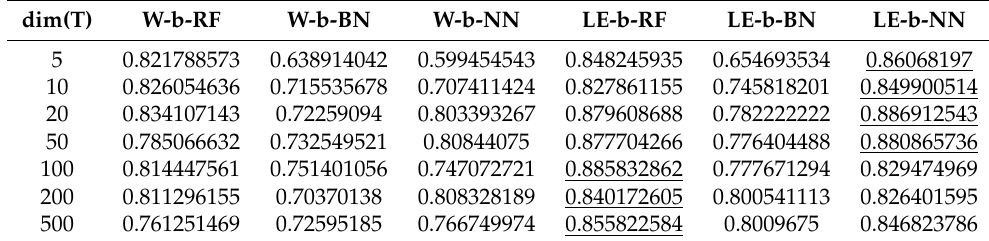
Table 6. F1-score with different dimensions.